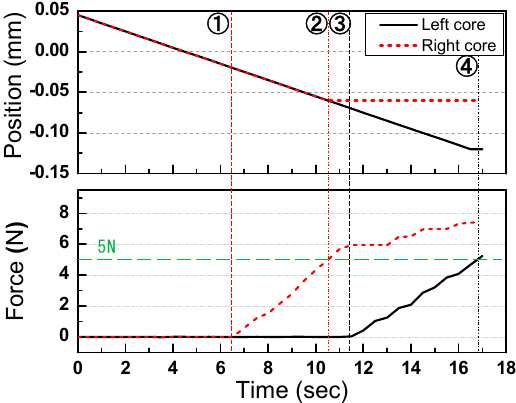
Figure 13. Test results under the reference force of 5 N and movement of 5 μ m.